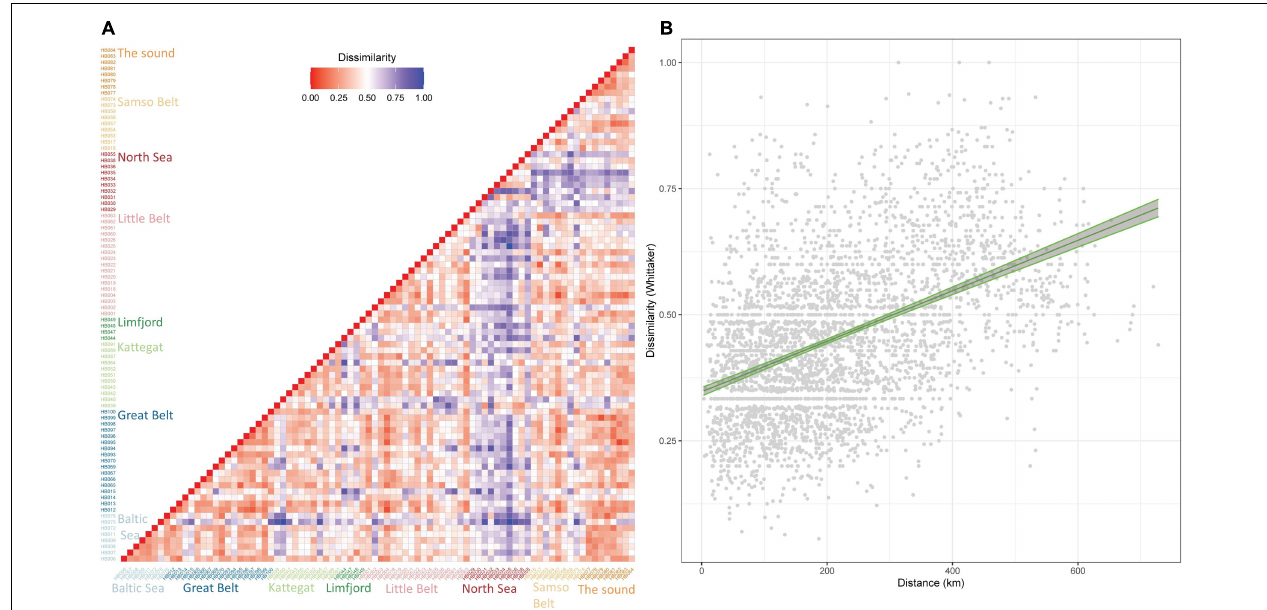
FIGURE 4 | (A) Presence-absence beta diversity between locations. A heatmap representing the Whittaker dissimilarity matrix among locations. Locations are colored according to sub-areas: North Sea (red), Limfjord (dark green), Kattegat (light green), Samso Belt (light orange), Great Belt (dark blue), Little Belt (pink), Baltic Sea (light blue) and The Sound (dark orange). There is a pattern that locations on the Danish west coast (“North Sea”) are more dissimilar to the other locations. (B) Using linear regression, there is a highly significant correlation between dissimilarity and distance between locations. Confidence intervals of 95% are shown in grey along the line with edges of the confidence intervals in